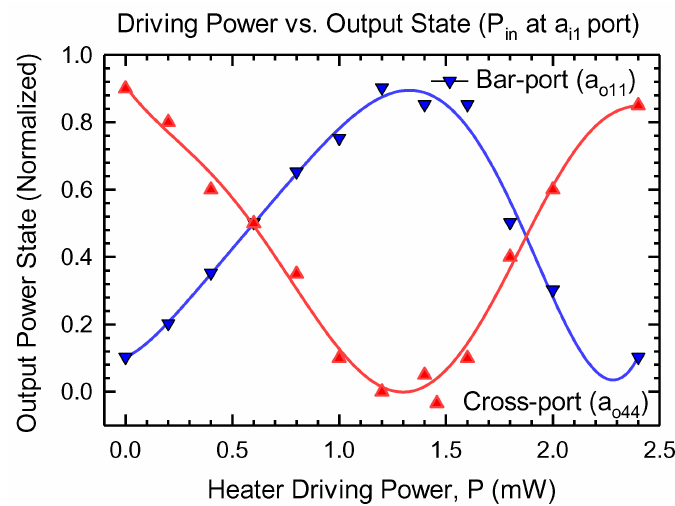
Figure 6. Calculated powers from the output ports of the MMI 2 : bar (a o 11 ) and cross (a o 44 ) as a function of the heating power in MMI 3 , and input is fed at a i 1 . The solid lines are fitted curve using KyPlot